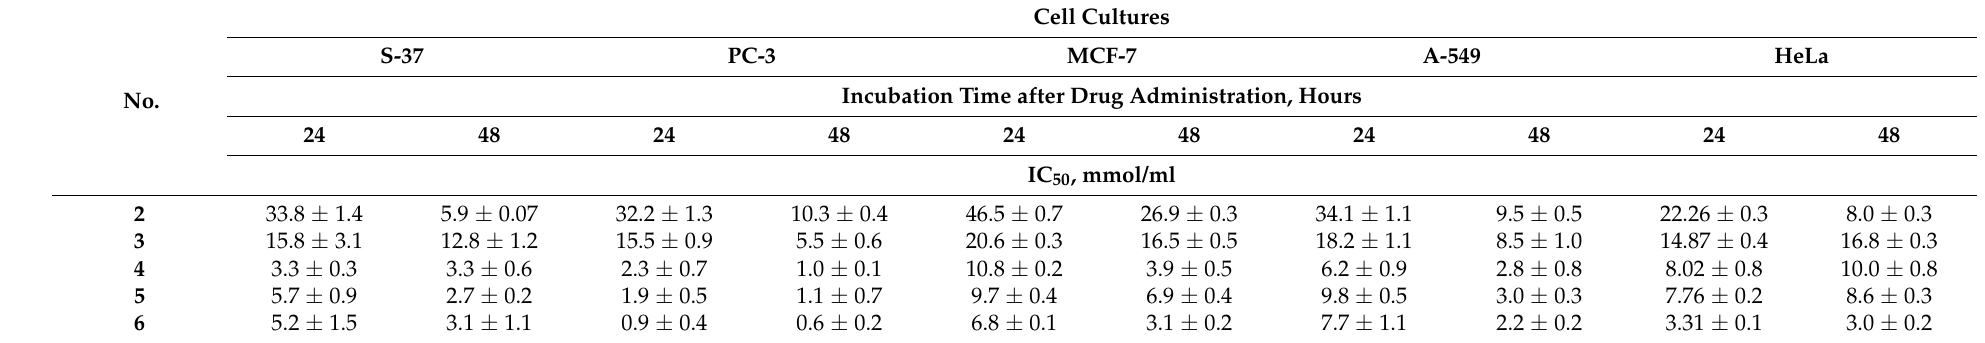
Table 2. Results of the dark cytotoxicity study.